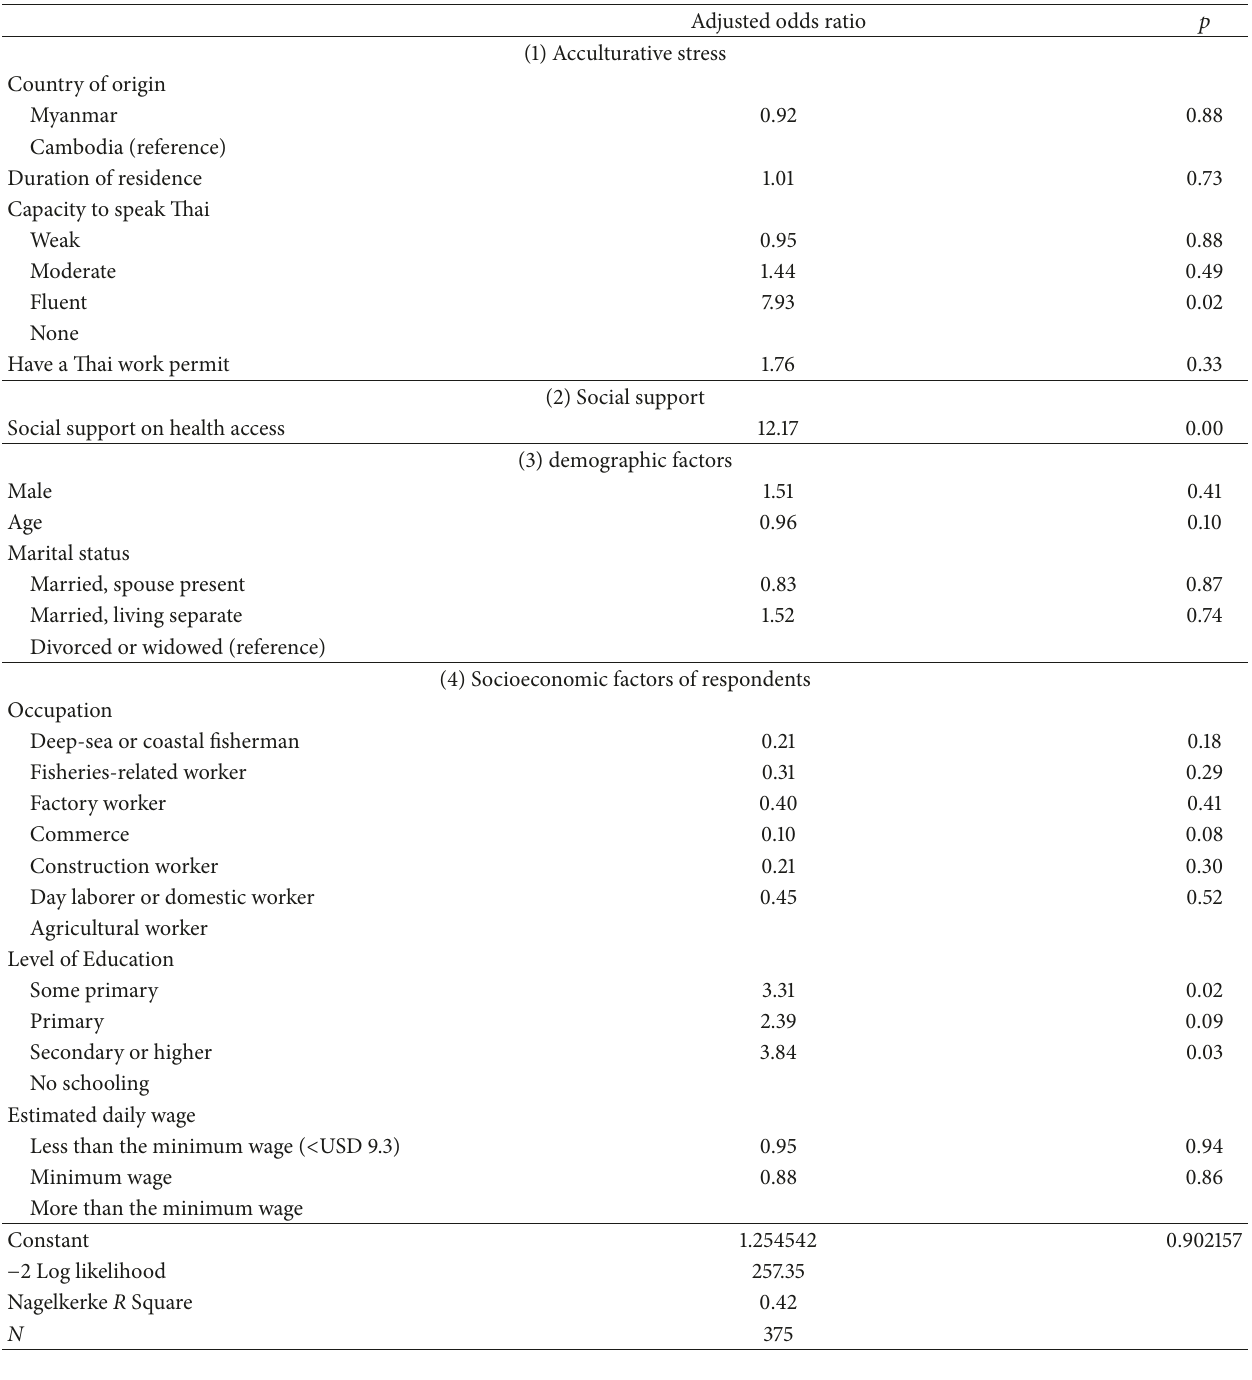
Table 2: Multivariate logistic regression analysis of factors related to obtaining ANC during the last pregnancy, among GMS migrant workers whose youngest child is aged 0–4